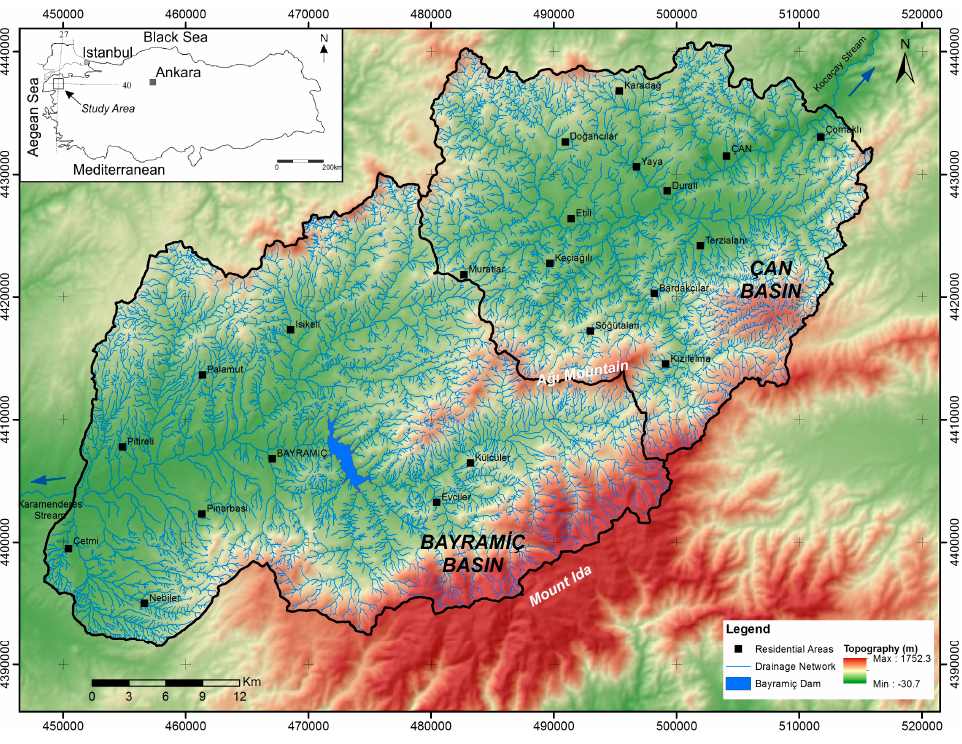
Figure 1. Location of study area.